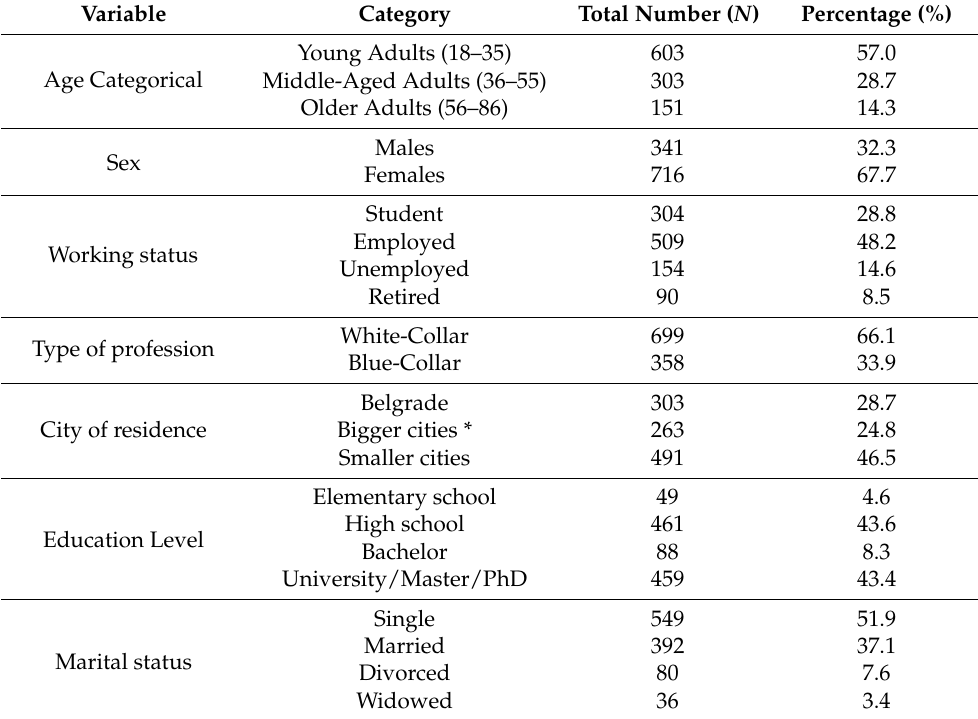
Table 1. Socio-demographic characteristics of study